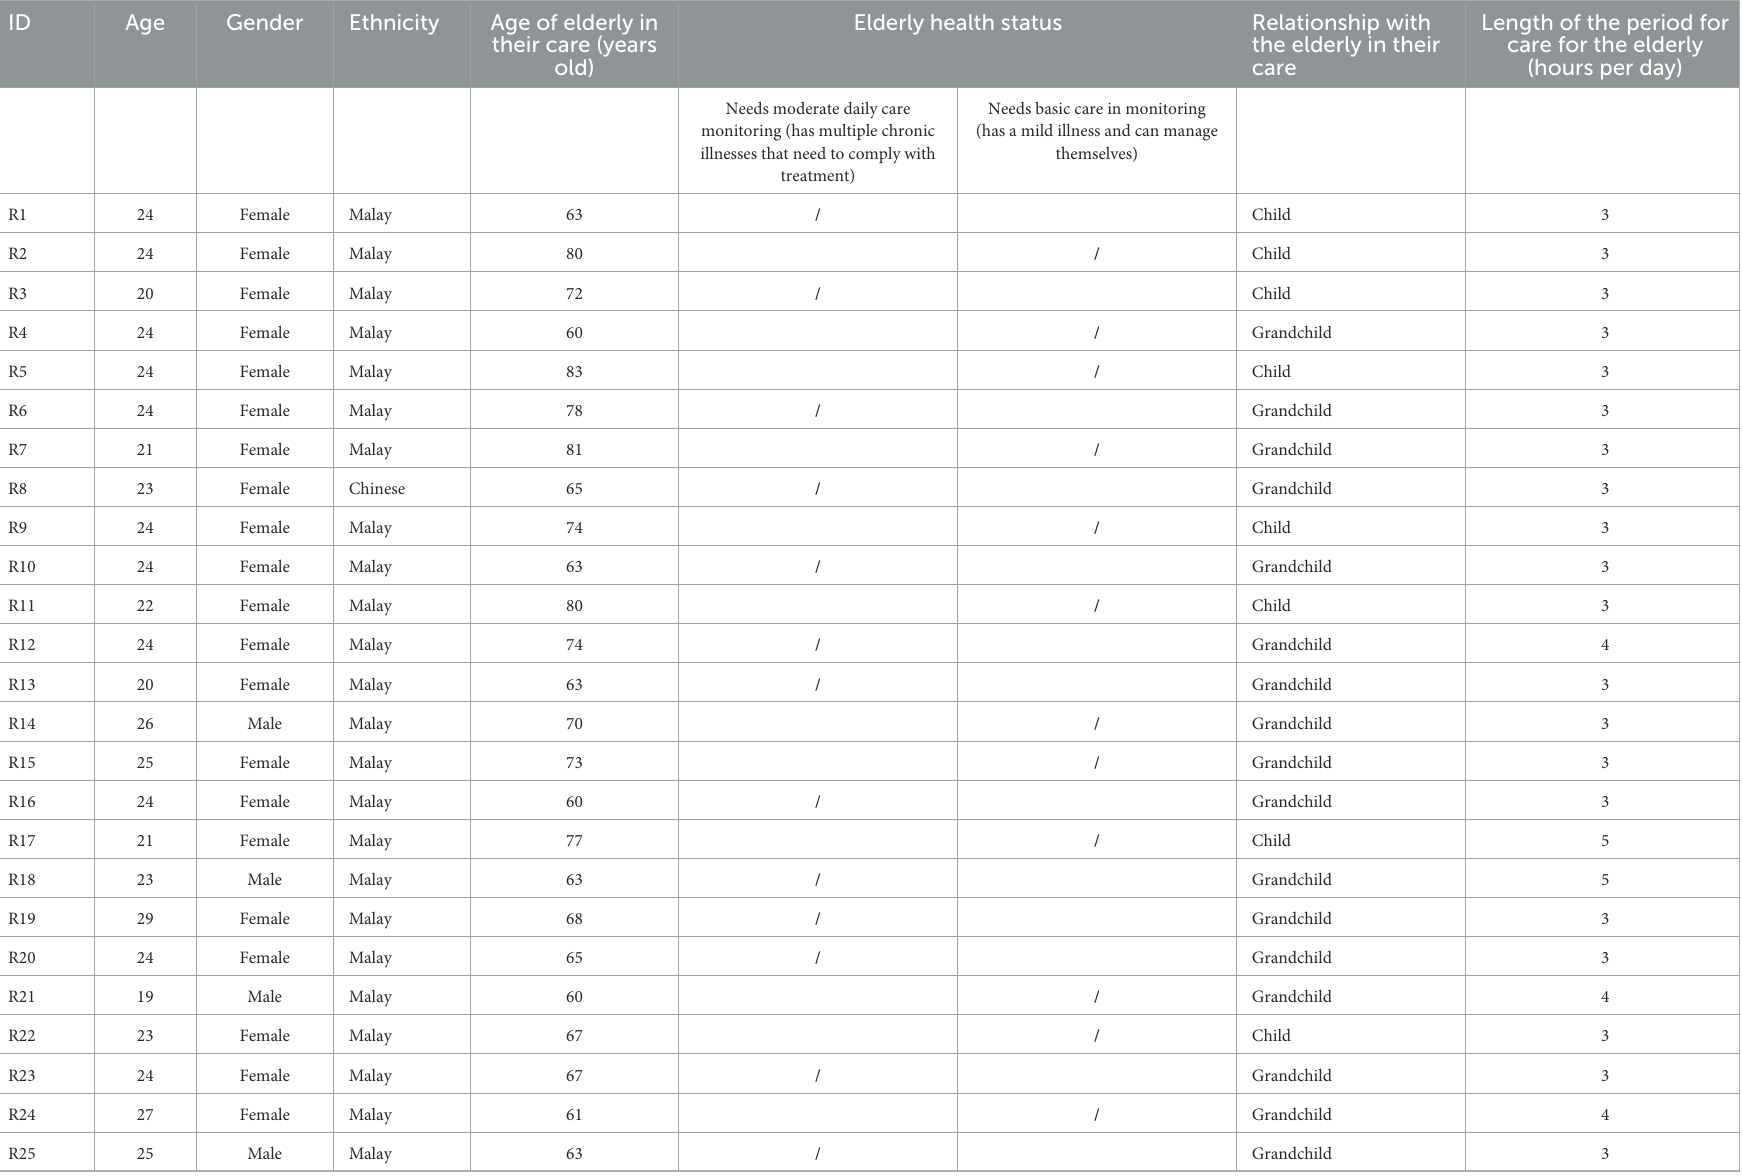
TABLE 3 Respondents’